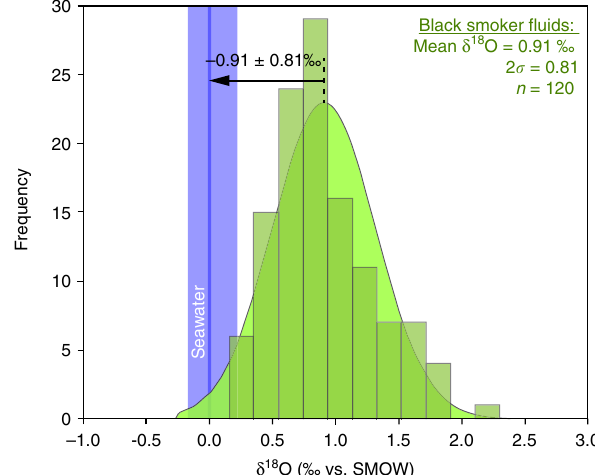
Fig. 6 Partial δ 18 O equilibration between present-day bottom seawater and black smoker fl uids. Distribution histogram and associated curve (in green) for a compilation of black smoker fl uids' δ 18 O values ( n = 120) 45 – 48 . Present-day bottom seawater range is represented in blue